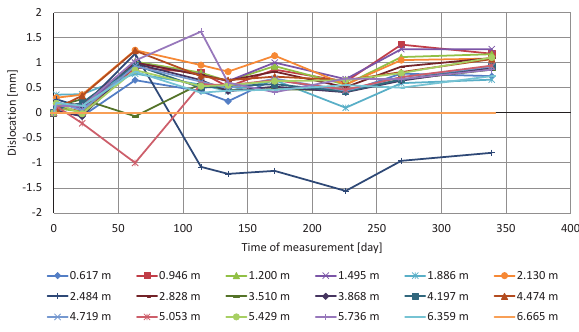
Fig. 6. Dislocation of particular anchors in the roof of S bypass of IIz shaft.